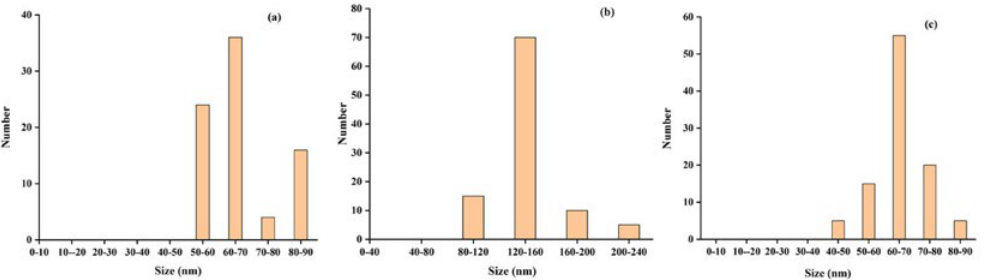
Fig. 9. Particle size histogram of CuO nanoparticles for [Cu